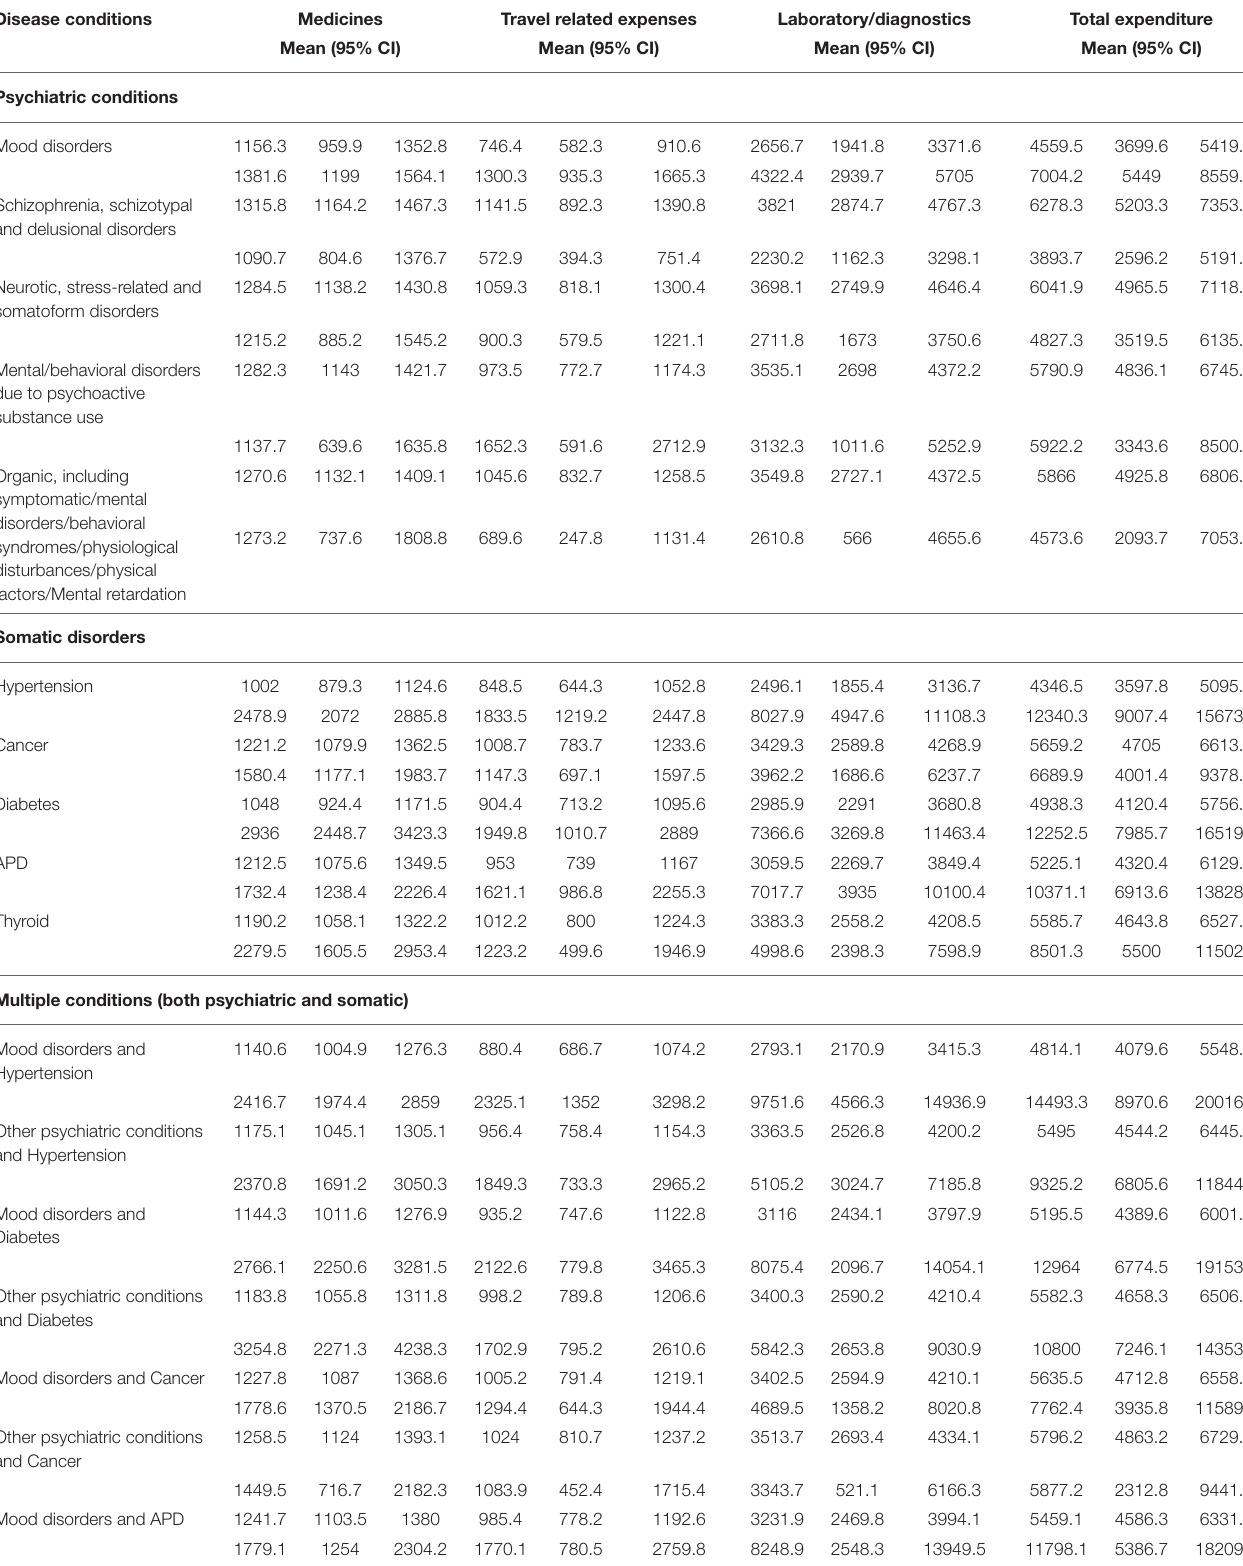
TABLE 6 | Variations in OOPE (In INR) by morbidity conditions among the sampled population. Disease